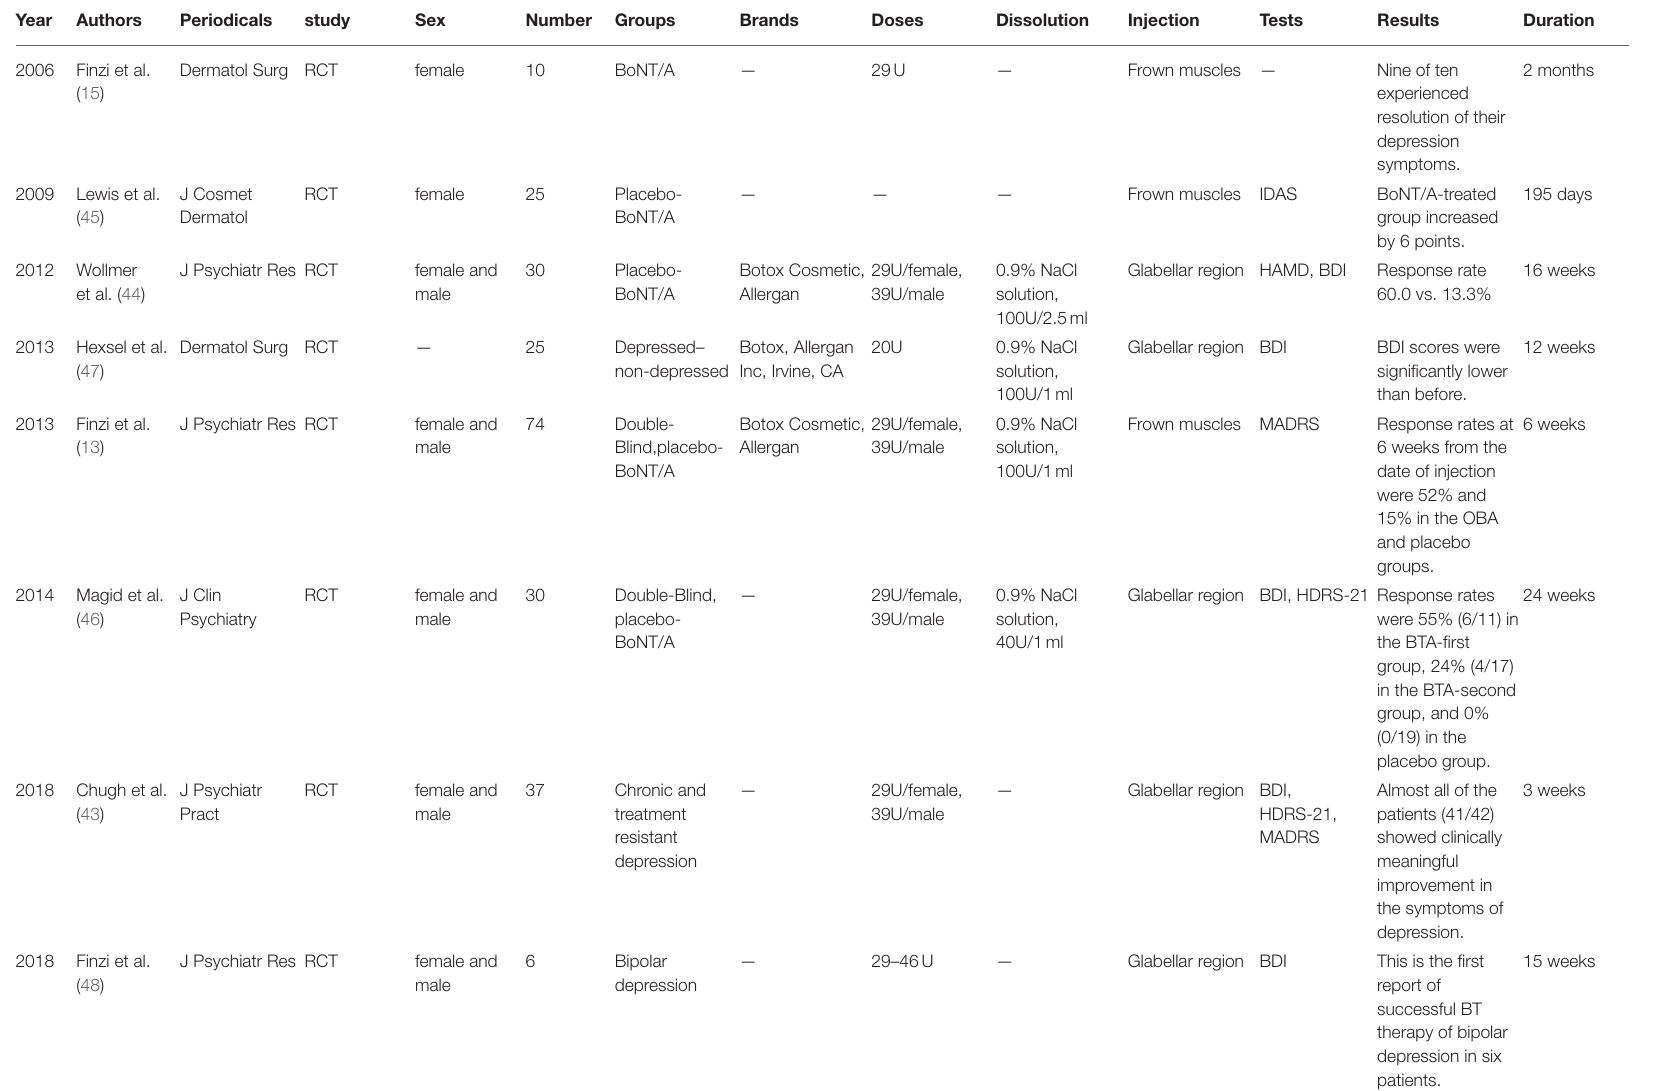
TABLE 1 | Clinical trials and preclinical studies on botulinum toxin in the treatment of